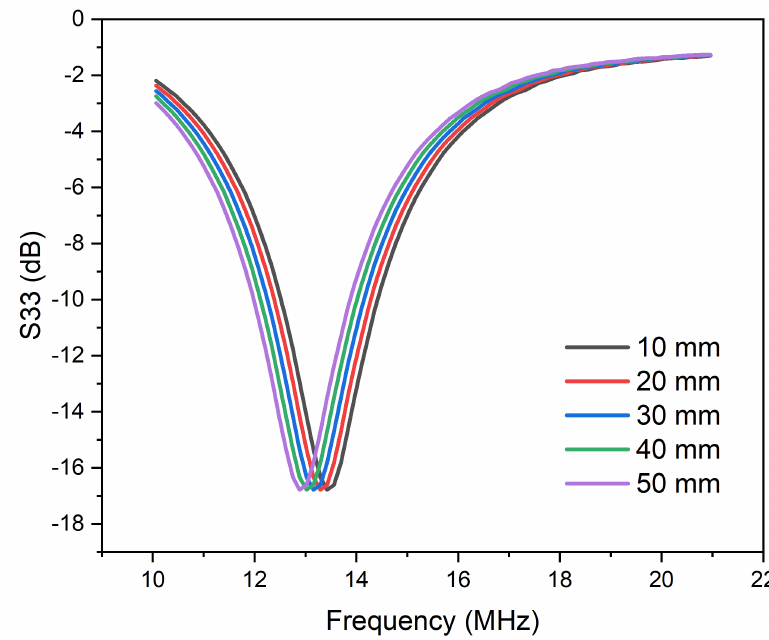
Figure 8. S 33 measured at different distances in the tissue medium.